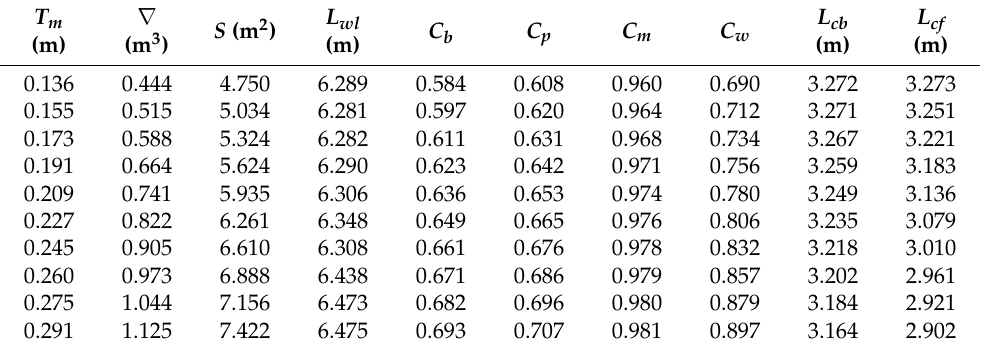
Table 2. Model ship features at different drafts.